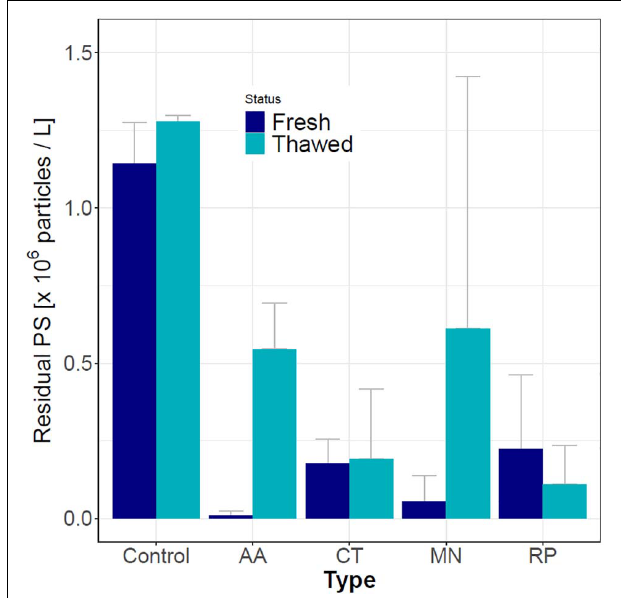
FIGURE 2 | Residual (water) PS concentration in control (no mucus) and in samples of mucus from four jellyfish species with fresh or thawed mucus. The used PS microspheres concentration was 1.6 × 10 6 /mL. AA – A. aurita ; CT – C. tuberculata ; MN – M. leidyi ; RP – R. pulmo . Each treatment had two biological and three technical